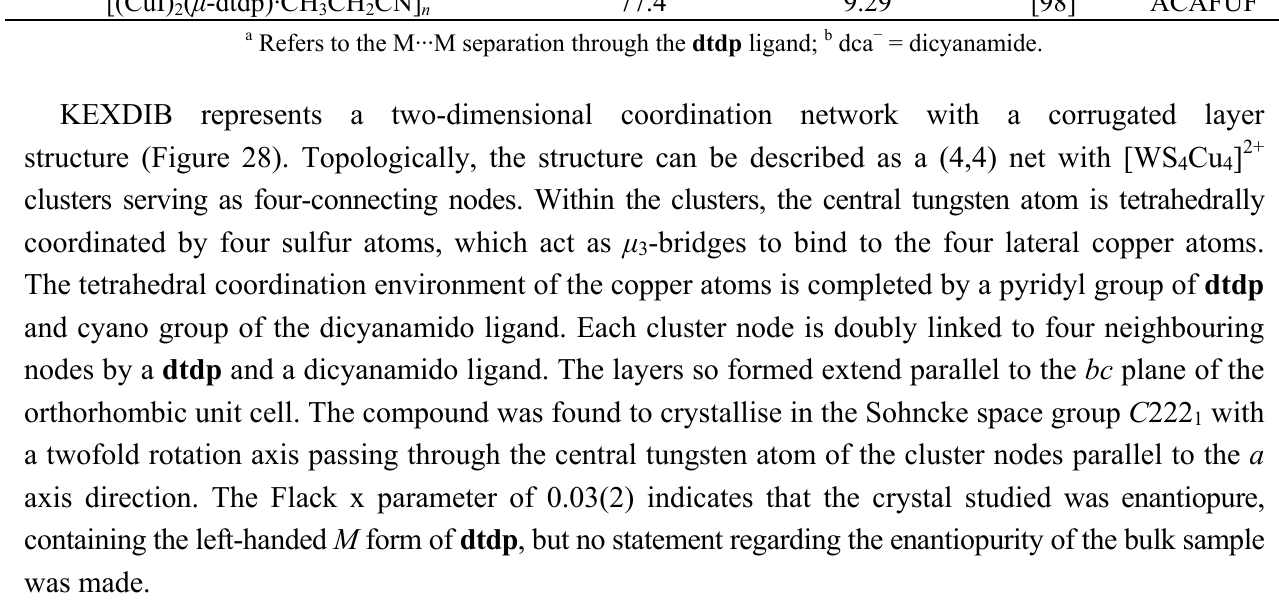
Cu ( μ -dca) ( μ - dtdp ) 4 4 2